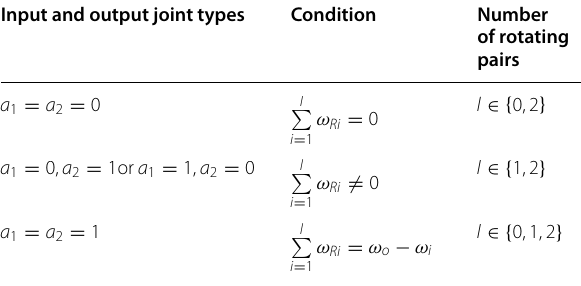
Table 1 Number of revolute joints under different input